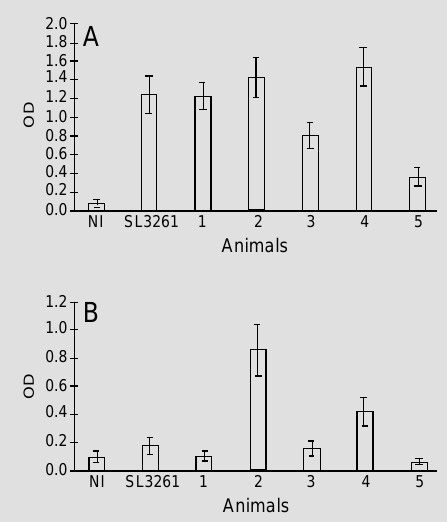
Figure 4 - Serum antibody re- sponse of mice immunized iv with S. typhimurium HG3 cells. The serum samples of 5 mice immunized with 10 9 cfu of HG3 were analyzed individually (num- bers 1 to 5) by IgG-ELISA for Salmonella LPS at a final dilution of 1:6,400 (A) and the CFA/I sub- unit at a final dilution of 1:400 (B). Results obtained with pools of non-immunized (NI) and SL3261-inoculated (SL3261) mouse sera are also shown. Re- sults are reported as the mean ± SD of quadruplicate wells of two identical experiments.